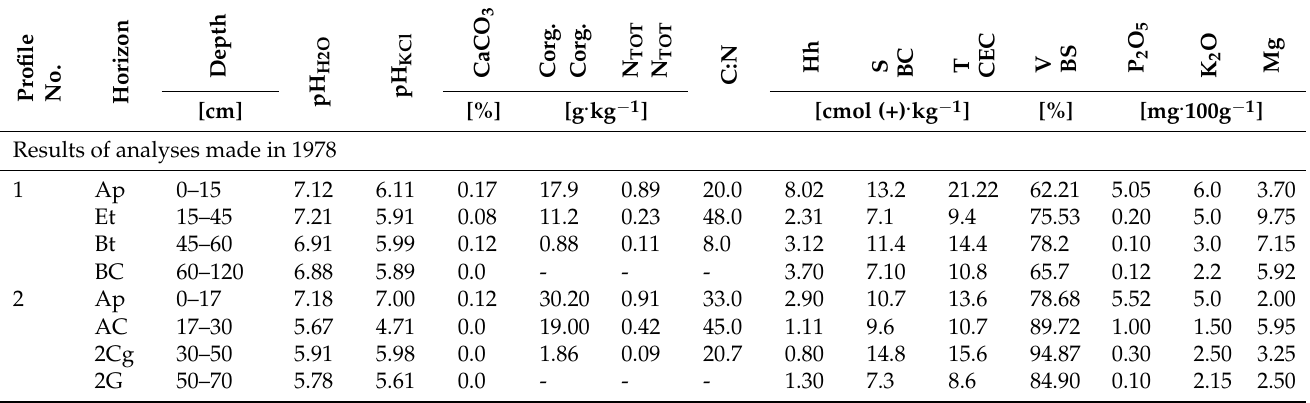
Table 4. Selected chemical characteristics of analysed